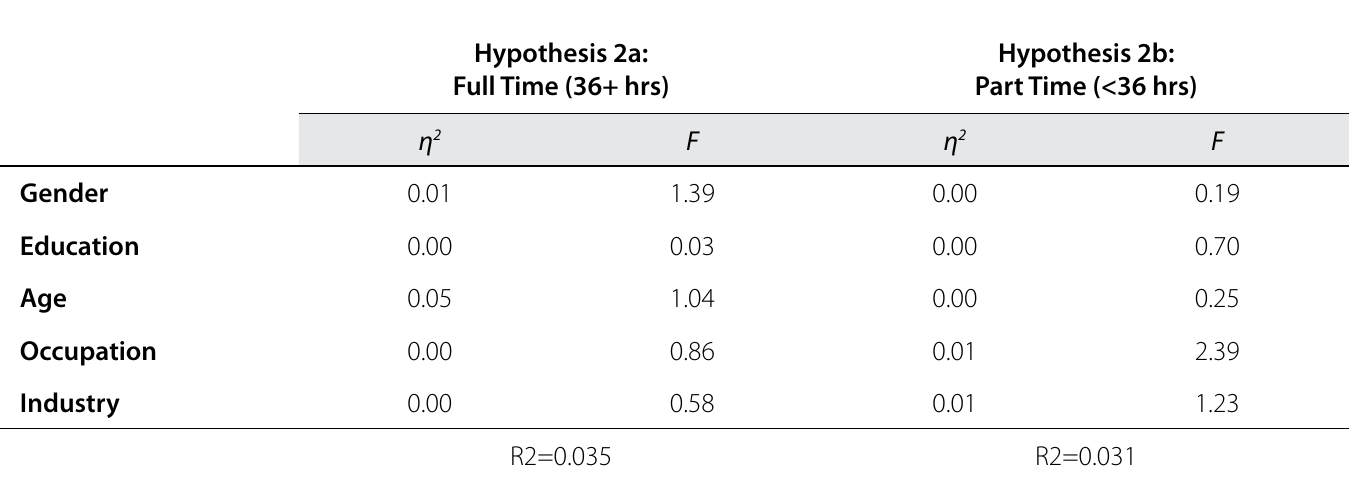
Table 3a. Means by Gender for Full-Time and Part-Time Employees